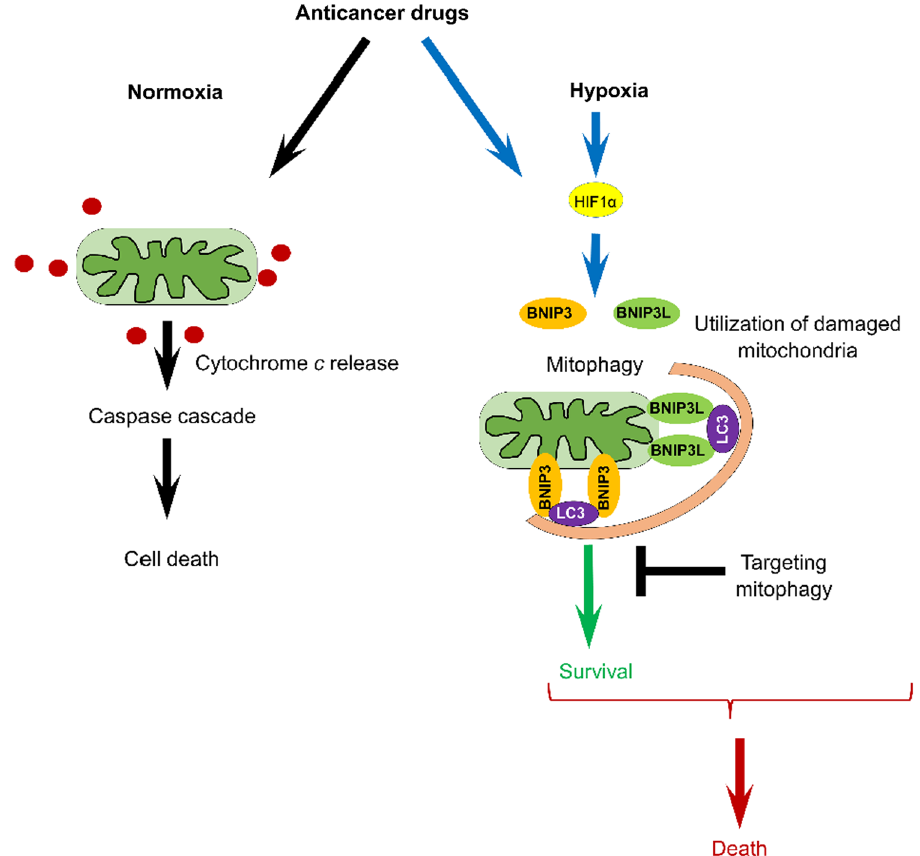
Fig. 2 Mitophagy modulates anticancer therapy (see the text for the